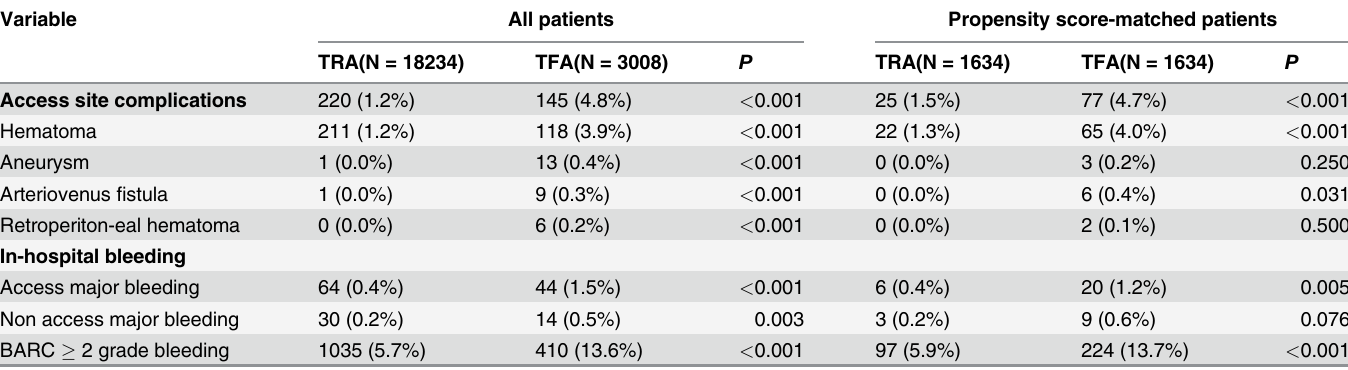
Table 5. Access site complications and